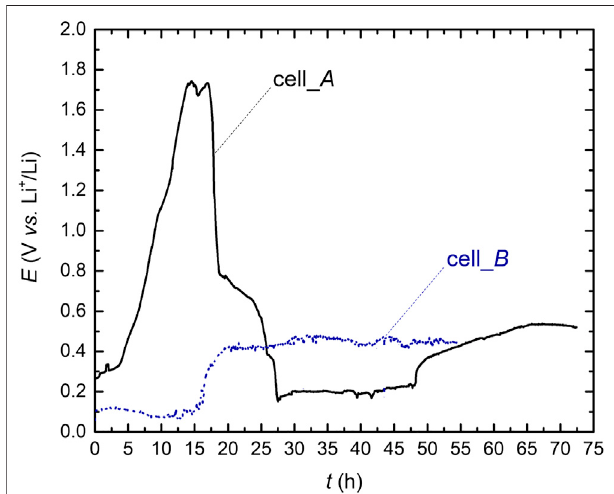
FIGURE 3 | Cell voltage at 25 ° C during the galvanostatic step for (solid curve) Cell_ A and (dotted curve) Cell_ B .